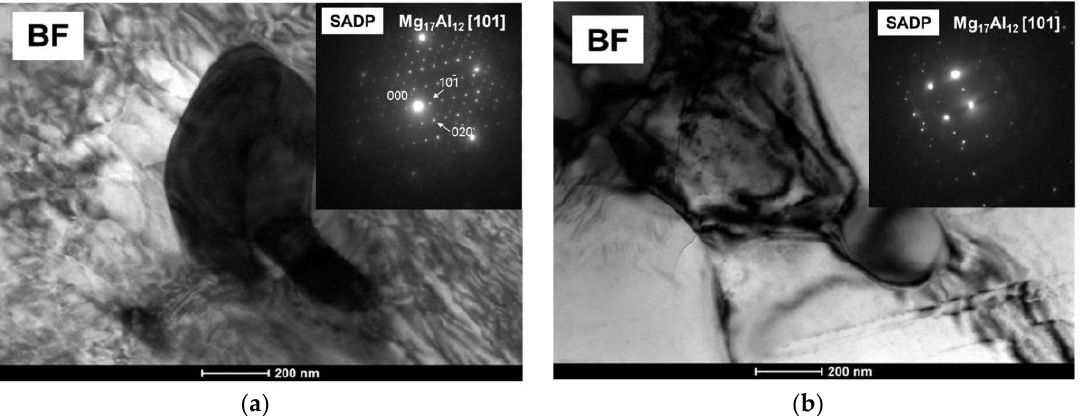
Figure 13. BF images with corresponding SADPs of samples after the first ( a ) and the third ( b ) pass by TCAP.